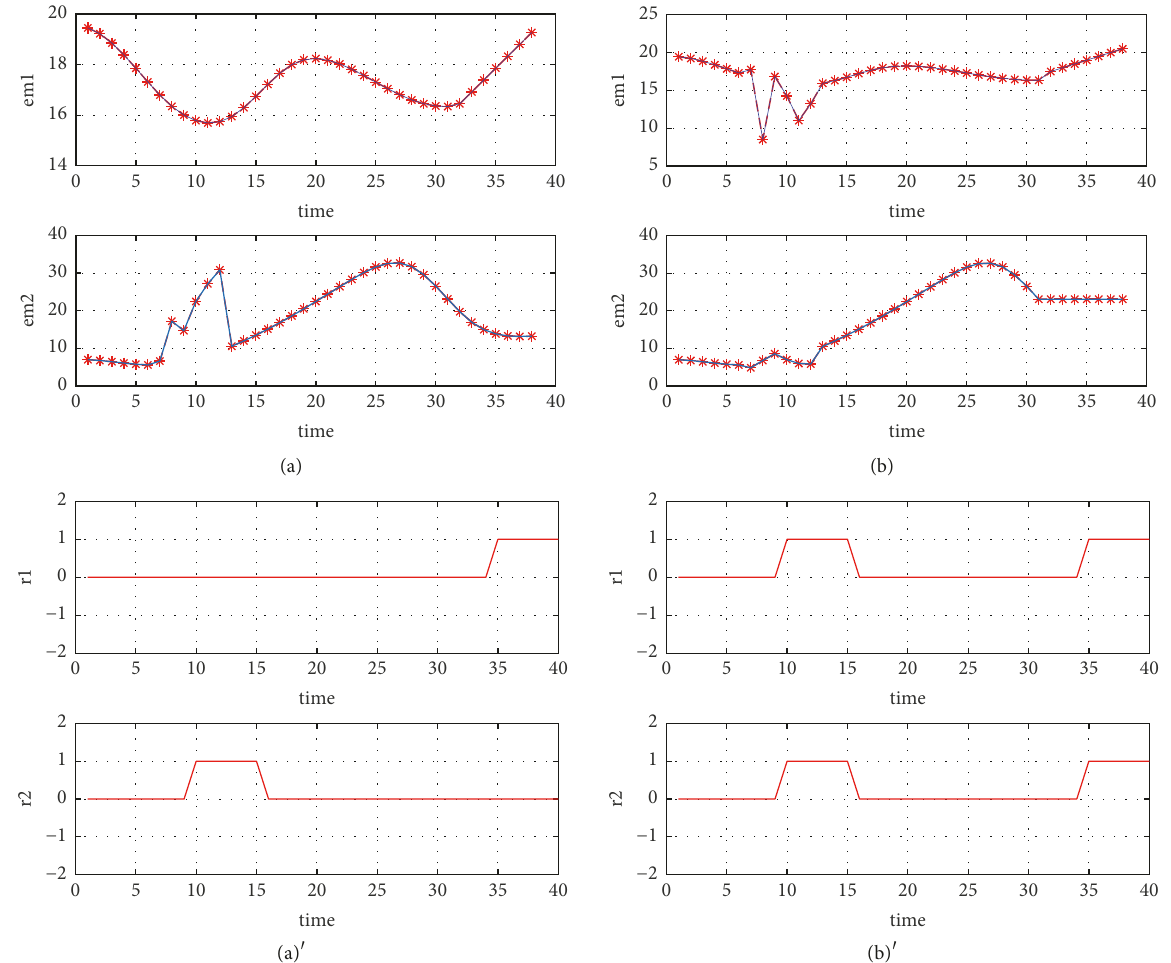
Figure 14: Two faulty IEMG signals (a) One fault in each signal, (b) Two faults in each signal (a) 󸀠 Normalized residue of (a), (b) 󸀠 Normalized residue of